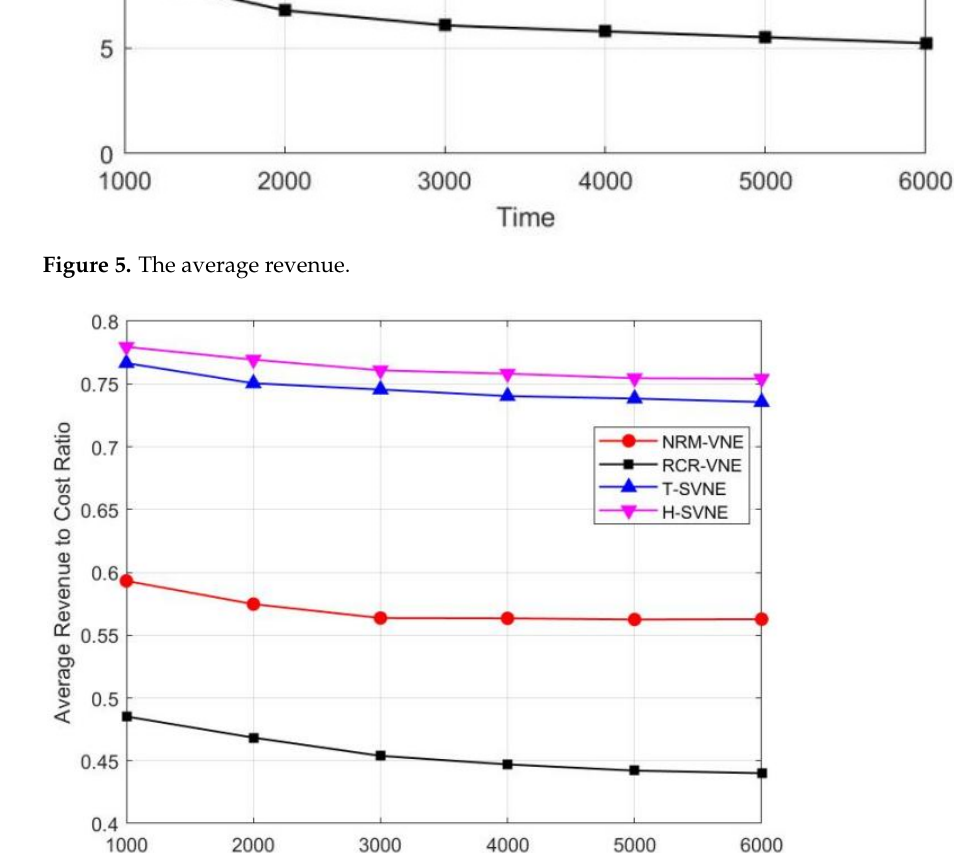
Figure 5. The average revenue.